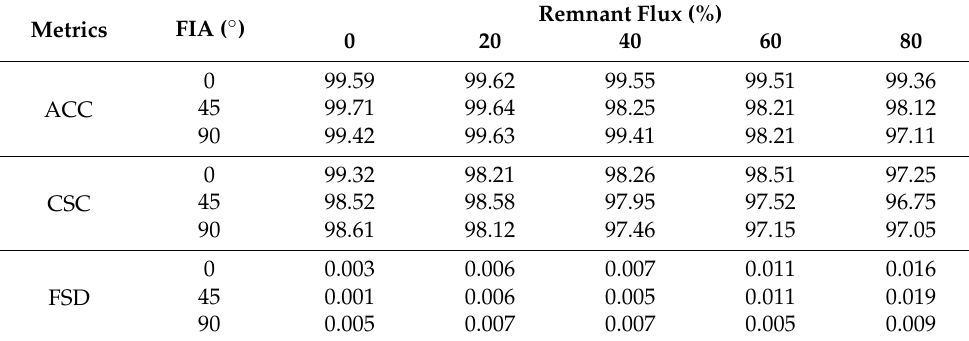
Table 4. Metrics measured from DNN for the 345kV system